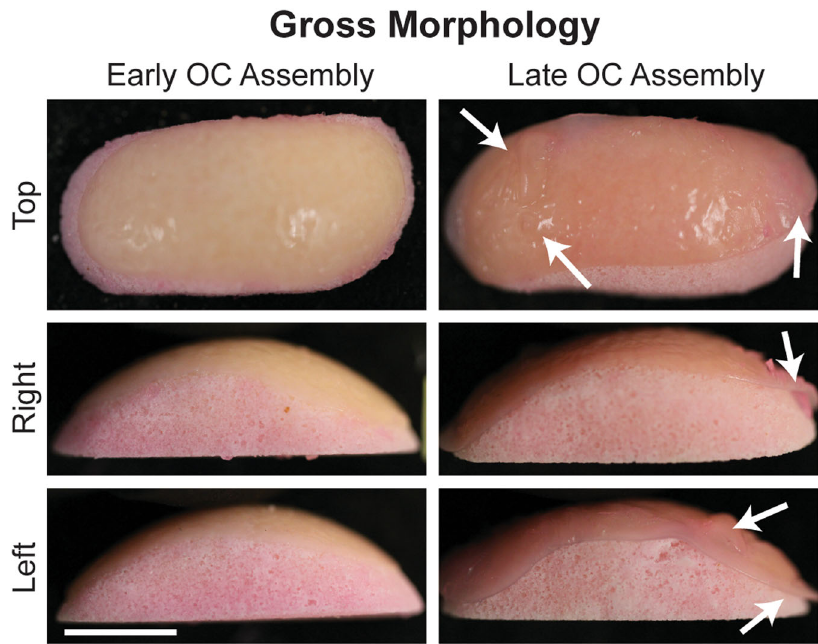
Fig. 2 Construct gross morphology. Top, right, and left views of osteochondral construct gross morphology. Arrows indicate regions where the neocartilage was deformed and not in contact with the HAp ceramic. The scale bar represents 10 mm. OC osteochondral.